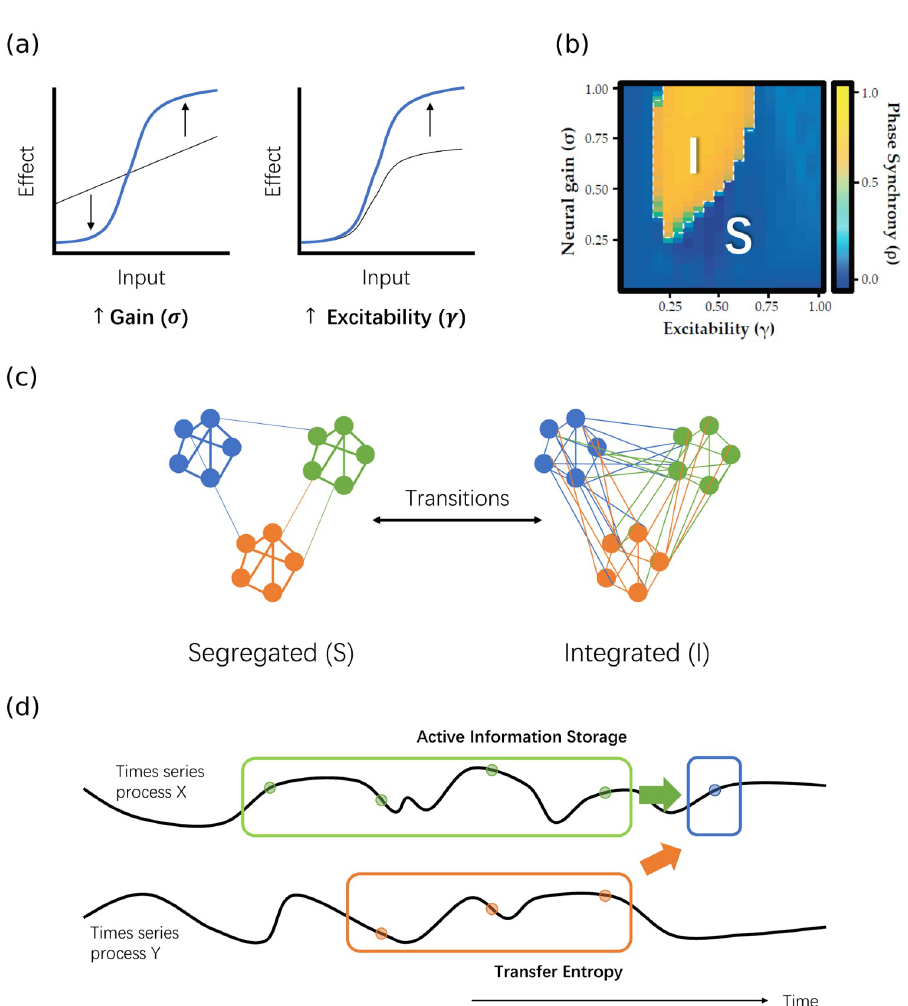
Fig 1. Schematic diagram showing how neural gain parameters (e.g. under modulation by noradrenaline) may potentially affect the information processing structure of the brain. (a) The effect of neural gain ( σ ) and excitability ( γ ), the two tuning parameters being varied in our neural mass model (see Methods), on the response of individual neurons to stimuli are shown schematically. Each input stimulus to a target region in the model contributes an effect to the rate of change of the target via a sigmoid function. Arrows in the figures indicate how the sigmoid function defining these effects changes with increases in these gain parameters (with σ increasing nonlinearity of response and γ increase amplification). (b) Previous results from [7] (adapted under Creative Commons Attribution License CC BY 4.0) showing that varying neural gain and excitability may cause abrupt changes in the mean phase synchrony of the brain from modelled fMRI BOLD recordings, implying the existence of a critical boundary between a segregated phase (“S”, low phase synchrony) and an integrated phase (“I”, high phase synchrony) in the brain. (c) Schematic diagram of functional brain networks in the segregated and integrated phases, and how changing neural gain and excitability may lead to transitions between the two. (d) Schematic diagram of the concept of active information storage and transfer entropy, and how they may be affected by phase transitions. Qualitatively, active information storage (green arrow) describes information on the next instance X (blue sample) of a time series X provided by its own history ( X ð k Þ , n +1 n green samples), whereas transfer entropy (orange arrow) describes that provided by the past ( Y ð l Þ , orange samples) of n another time series Y in the context of the target’s history. See further details on these measures in